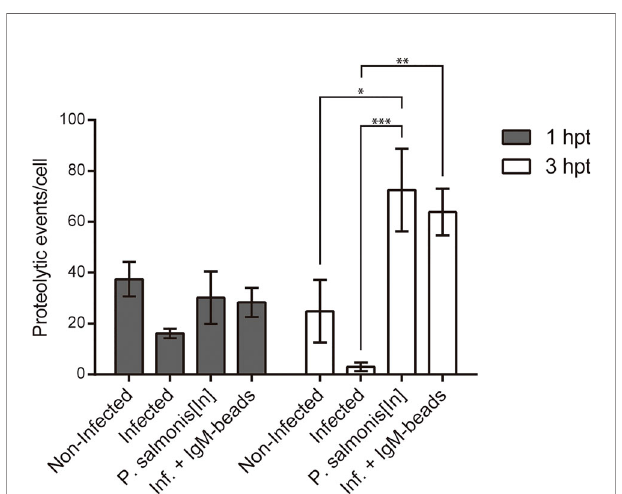
FIGURE 4 | Quanti fi cation of proteolytic events in infected macrophage- enriched cell cultures treated with igM-beads. Macrophage-enriched cell cultures were infected with P. salmonis at a MOI of 10 bacteria/cell and analyzed at 1 and 3 hpt. The proteolytic events were detected using the DQ- BSA ™ Green probe and data were quanti fi ed and normalized to the number of cells analyzed for each condition. The statistical analysis was performed through a parametric ANOVA with a Tukey multiple comparison test. Signi fi cant differences: *p <0.05, **p < 0.01, ***p<0.001.